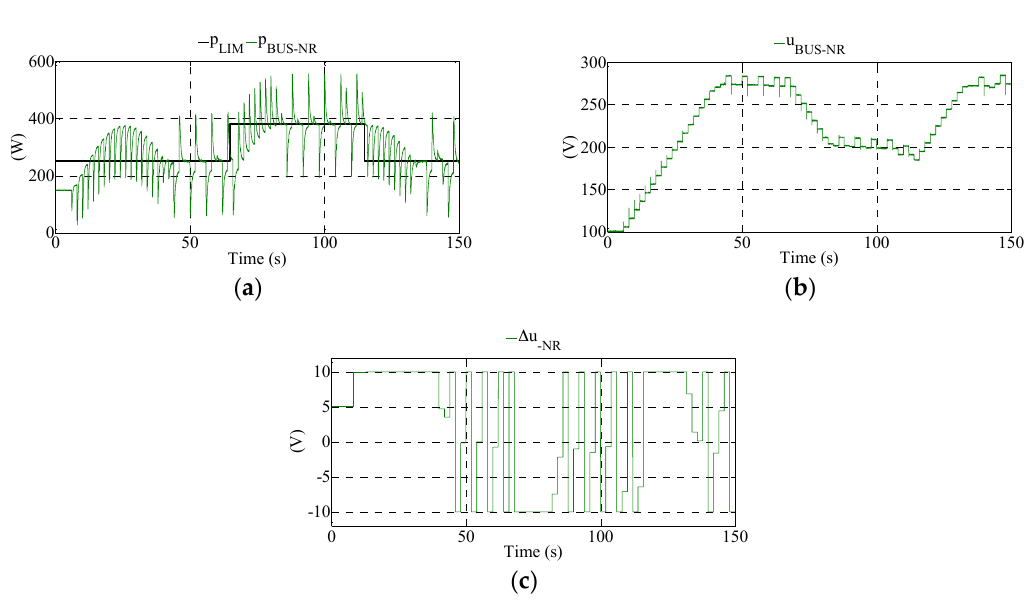
Figure 8. Canonical Newton–Raphson method: ( a ) Evaluations of p BUS ; ( b ) Evaluations of u BUS ; ( c ) Evaluations of ∆ u